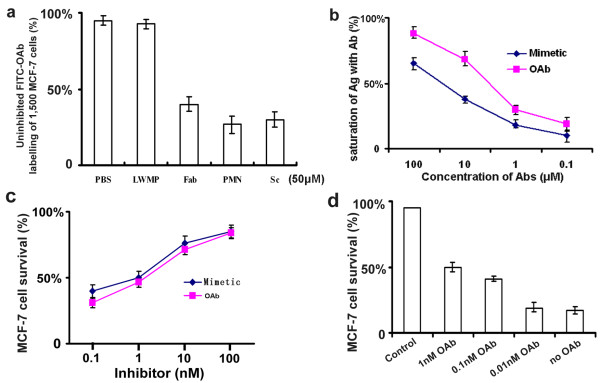
The competition ability of synthetic VHFR1C-10-VHCDR1-VHFR2-VLCDR3-VLFR4N-10. (a) Fixed MCF-7 cells were incubated with PBS, LWMP, Fab, PMN and Sc-Fv peptides (50 μM) and DAPI (50 ng/ml) prior to flow cytometry. LWMP, low molecular weight marker protein; Fab, Fab segment from original antibody; PMN, protomimecin; Sc-Fv, ScFv segment from original antibody. (b) The relative affinity of VHFR1C-10-VHCDR1-VHFR2-VLCDR3-VLFR4N-10 peptides and OAbs to antigen. OAb, original antibody. (c) Concentration-dependent inhibition of different concentration of synthetic mimetic antibody or OAb against 75 μg/ml PMN. (d) MCF-7 cell survival ratio of the inhibition activity of OAb against PMN (75 μg/ml). OAb, original mAb antibody A520C9.